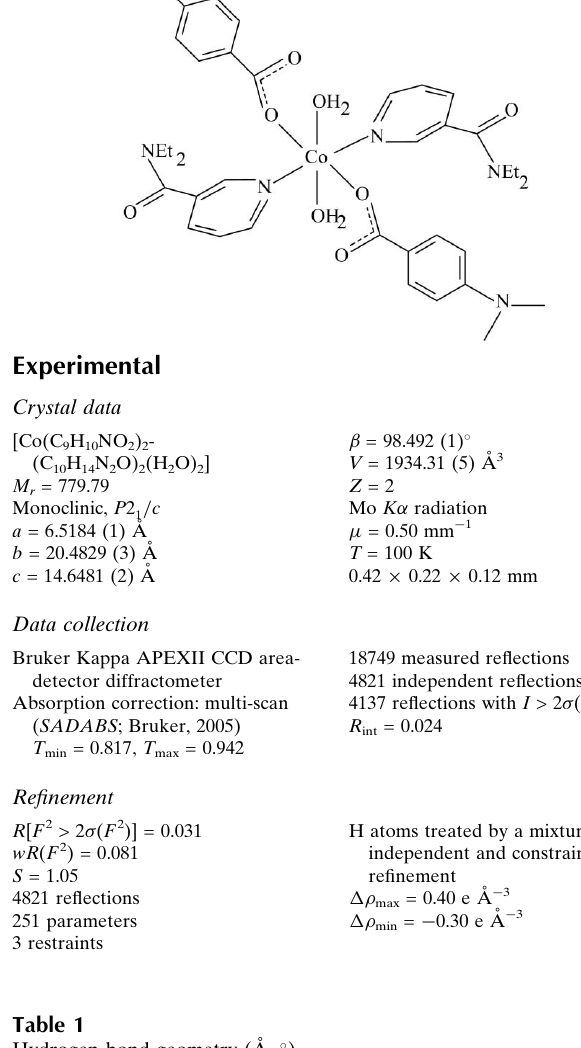
Hydrogen-bond geometry (A˚ , (cid:3)